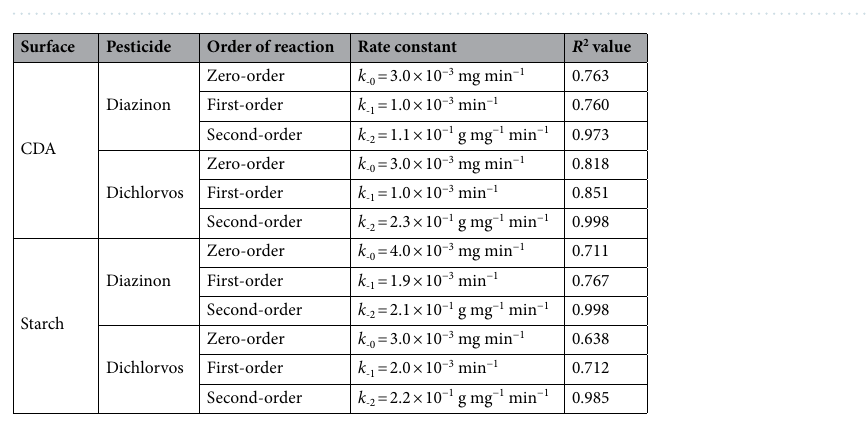
Figure 4. Second-order kinetic plots for the desorption of diazinon and dichlorvos from ( A ) CDA surface and ( B ) from starch surface into water at pH 7.0 and 27 °C.